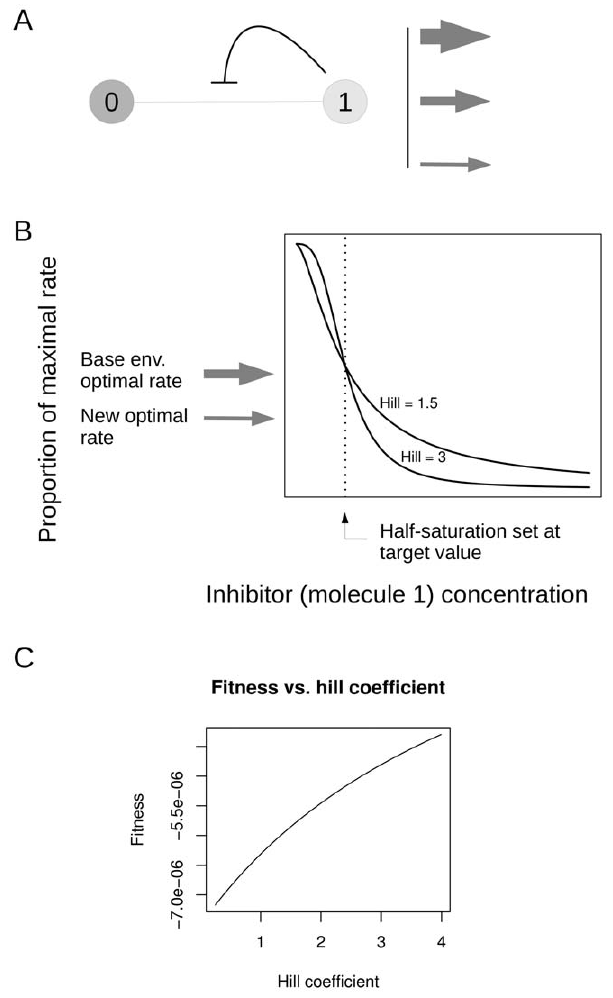
Figure 2. A simple example network with regulation. A. The network consists of two molecules connected by one reaction. The reaction is inhibited by the product molecule 1. There are fixed rate outflow reactions from molecule 1. These take on different levels in different environments, as illustrated by the arrows. B. Plot of the activity of the enzyme vs. concentration of the inhibitor (molecule 1). The two curves have half-saturation at molecule 1’s target value, and illustrate the shape with two different Hill coefficients. C. A plot showing how fitness varies with Hill coefficient for this network, given that the half-saturation is set to molecule 1’s target. Fitness (see text for definition) reflects the deviation of molecule 1 from its target and thus is in units of concentration.